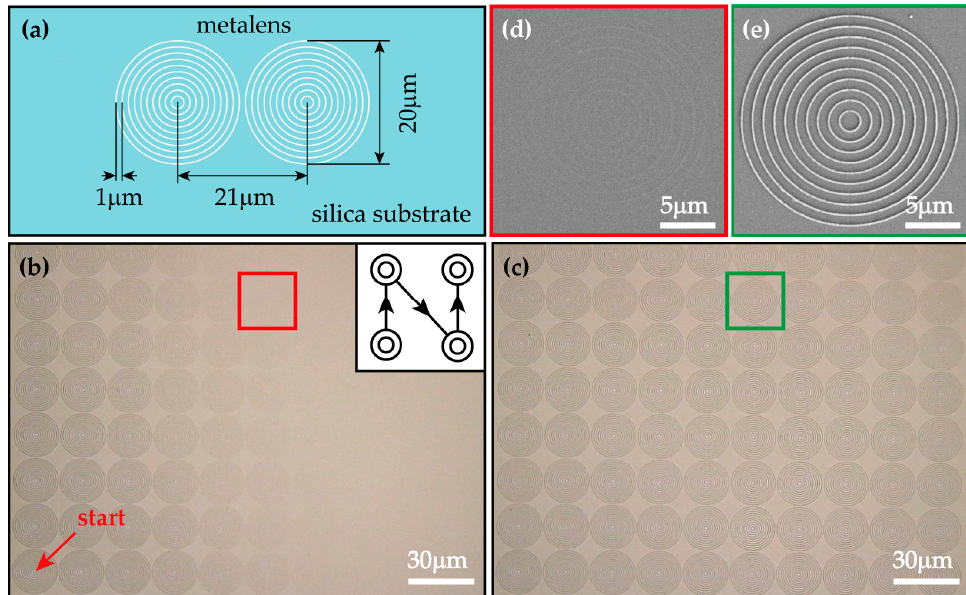
Figure 7. Fabrication of 8 × 10 metalens array with autofocus off and on. ( a ) Scheme of the designed metalens. The structure consists of concentric rings with a radius interval of 1 µm and a maximum diameter of 20 µm. The distance between the center of the structures is 21 µm. ( b ) Optical image of the metalens array fabricated with the autofocus off. The red arrow indicates the first printing position. The inserted figure shows the printing route. ( c ) Optical image of the metalens array fabricated with the autofocus on. ( d , e ) Zoomed-in SEM image of a single metalens indicated by the red and green rectangle in ( b ) and ( c ), respectively.